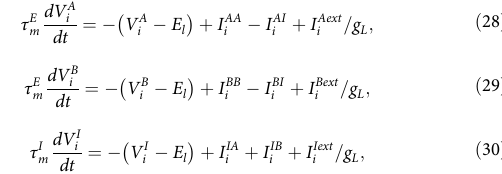
ffiffiffiffiffiffiffiffiffiffiffiffiffiffiffiffiffiffiffiffiffiffiffiffiffiffiffiffiffiffiffi φ 00 x ð Þ φ 00 x E